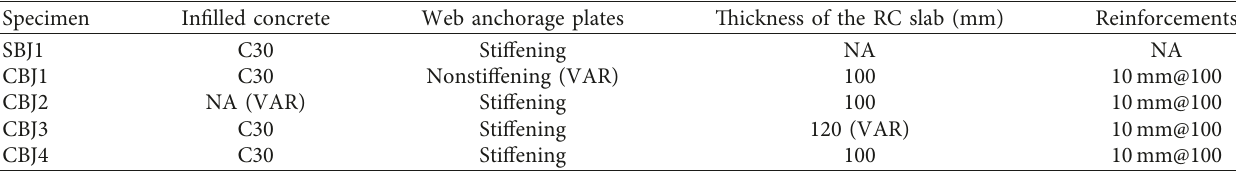
Table 1: Details of the test